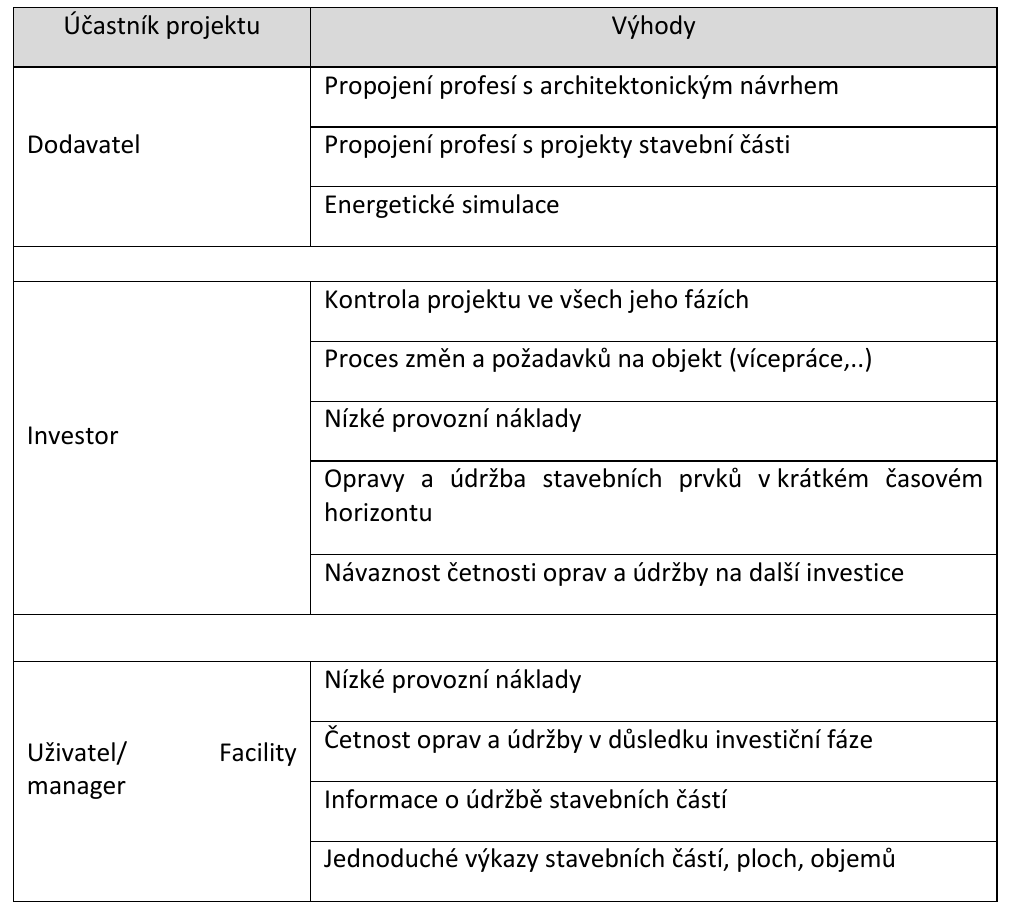
Tab. 2: Přehled výhod pro jednotlivé účastníky projektu při používání BIM (zdroj: